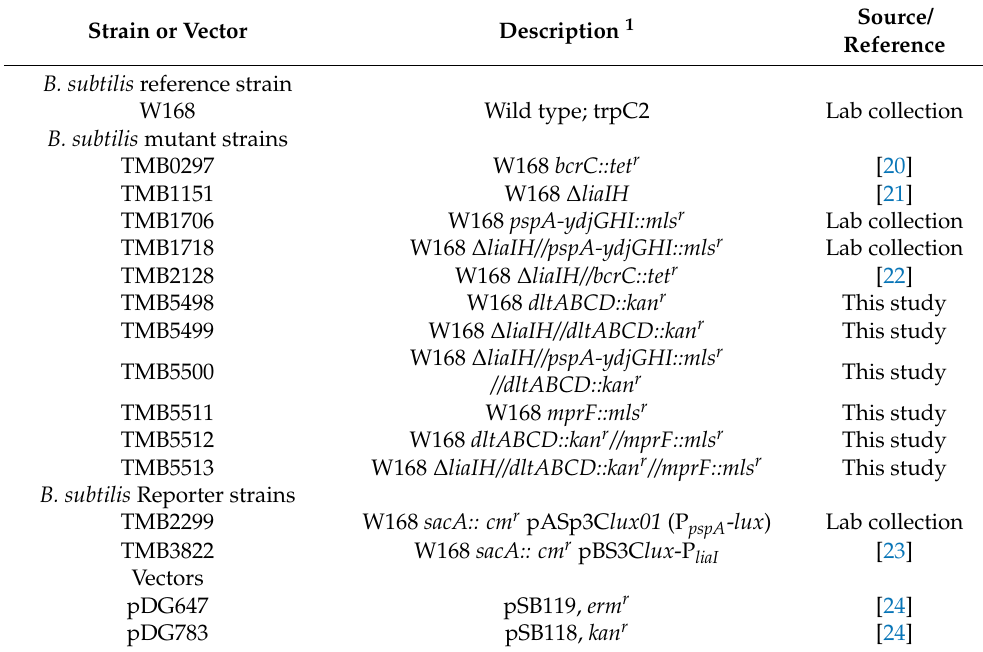
Table 1. Bacterial strains and vectors used in this